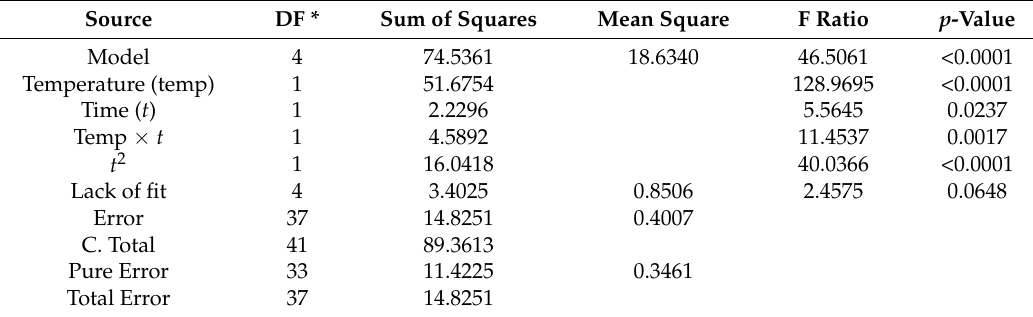
Table 5. ANOVA for effect of time ( t ) and temperature (temp) for in vitro protein digestibility for microwave processing.